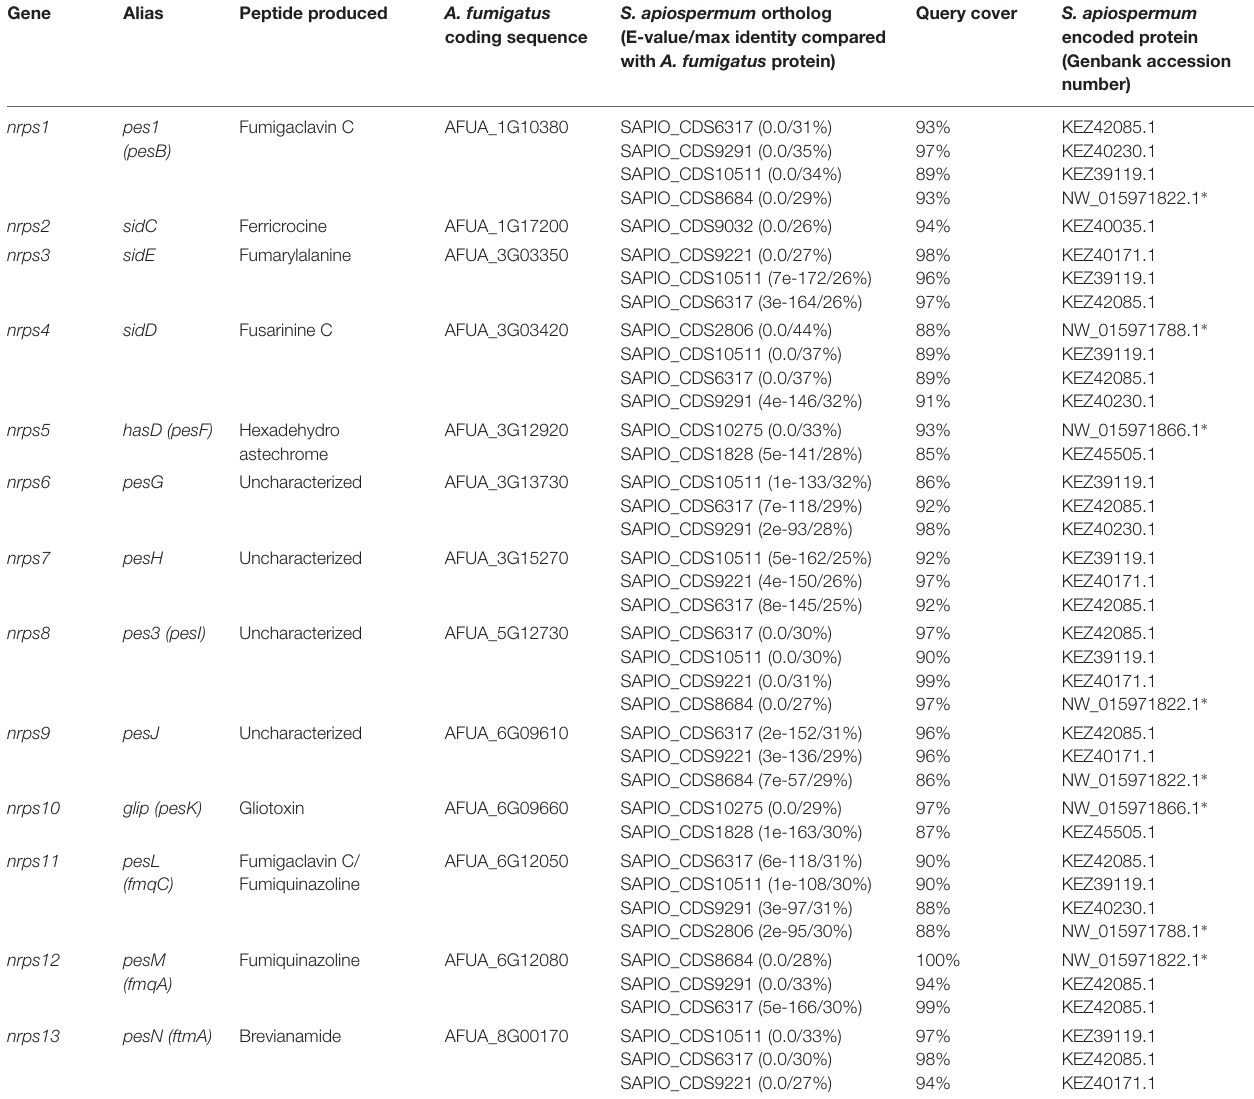
TABLE 1 | Results of tBLASTn analysis of the genes involved in non-ribosomal peptide synthesis in A. fumigatus Af293 (taxid:330879) against S. apiospermum (taxid:563466). Gene Alias Peptide